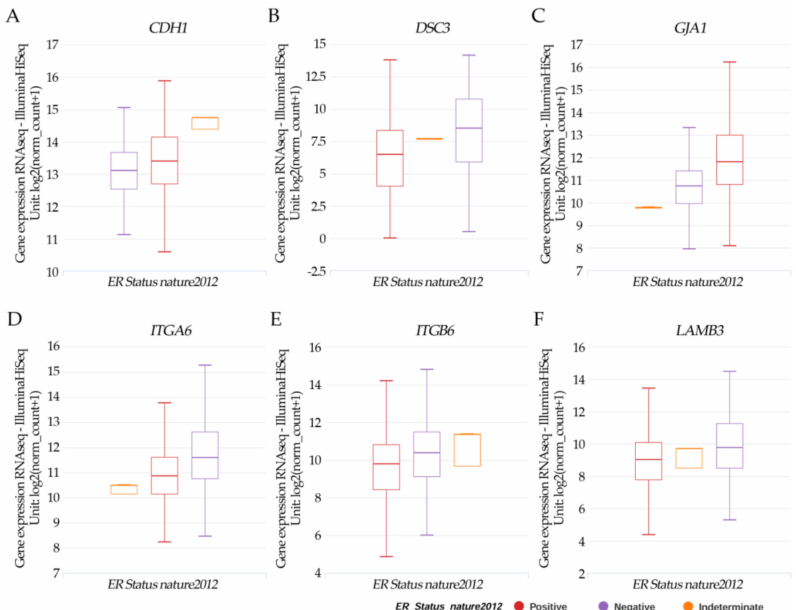
Figure 4. Xena Chart View showing box plot transcript expressions of ( A ) CDH1 , ( B ) DSC3 , ( C ) GJA1 , ( D ) ITGA6 , ( E ) ITGB6 , and ( F ) LAMB3 in breast cancer (cohort: TCGA Breast Cancer (BRCA), n = 1247) stratified by nature2012 for estrogen receptor status (One-way ANOVA, p < 0.05). Raw data were extracted from the University of California, Santa Cruz (http://xena.ucsc.edu/ (accesses on 20 August 2021)). UCSC Xena functional genomics explorer (https://xenabrowser.net accessed on 20 August 2021) [43].